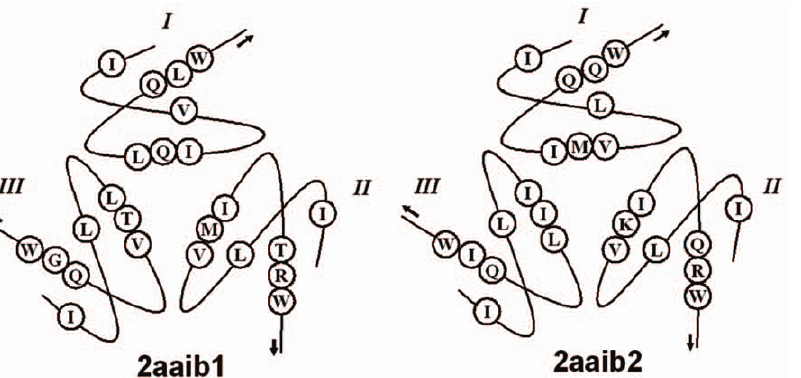
Figure 3. Schematic diagrams of four three-fold repetitive motifs (one-letter in circles) in two domains of RTB. The three trefoil units are shown in clockwise order. The arrows indicate the directions of beta strands.